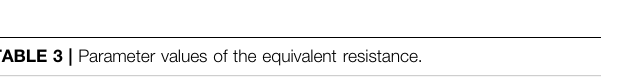
TABLE 3 | Parameter values of the equivalent